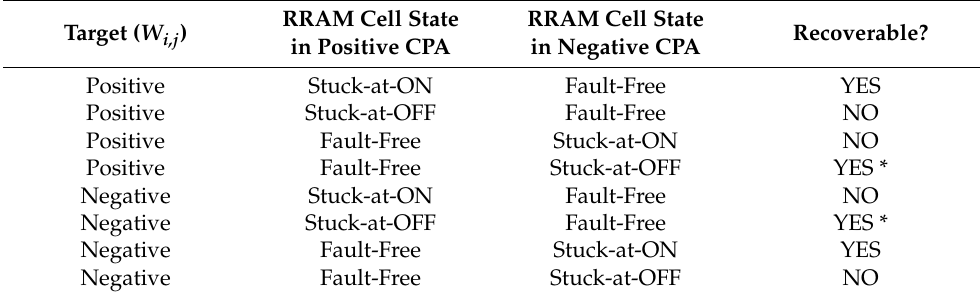
Table 2. Recoverable and unrecoverable fault